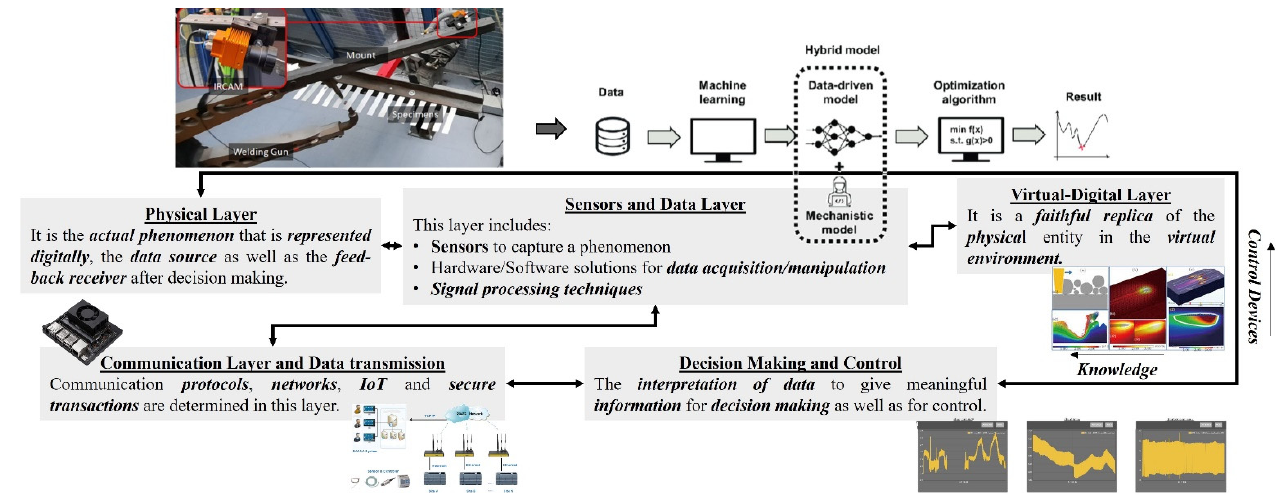
Figure 4. Digital Twin components